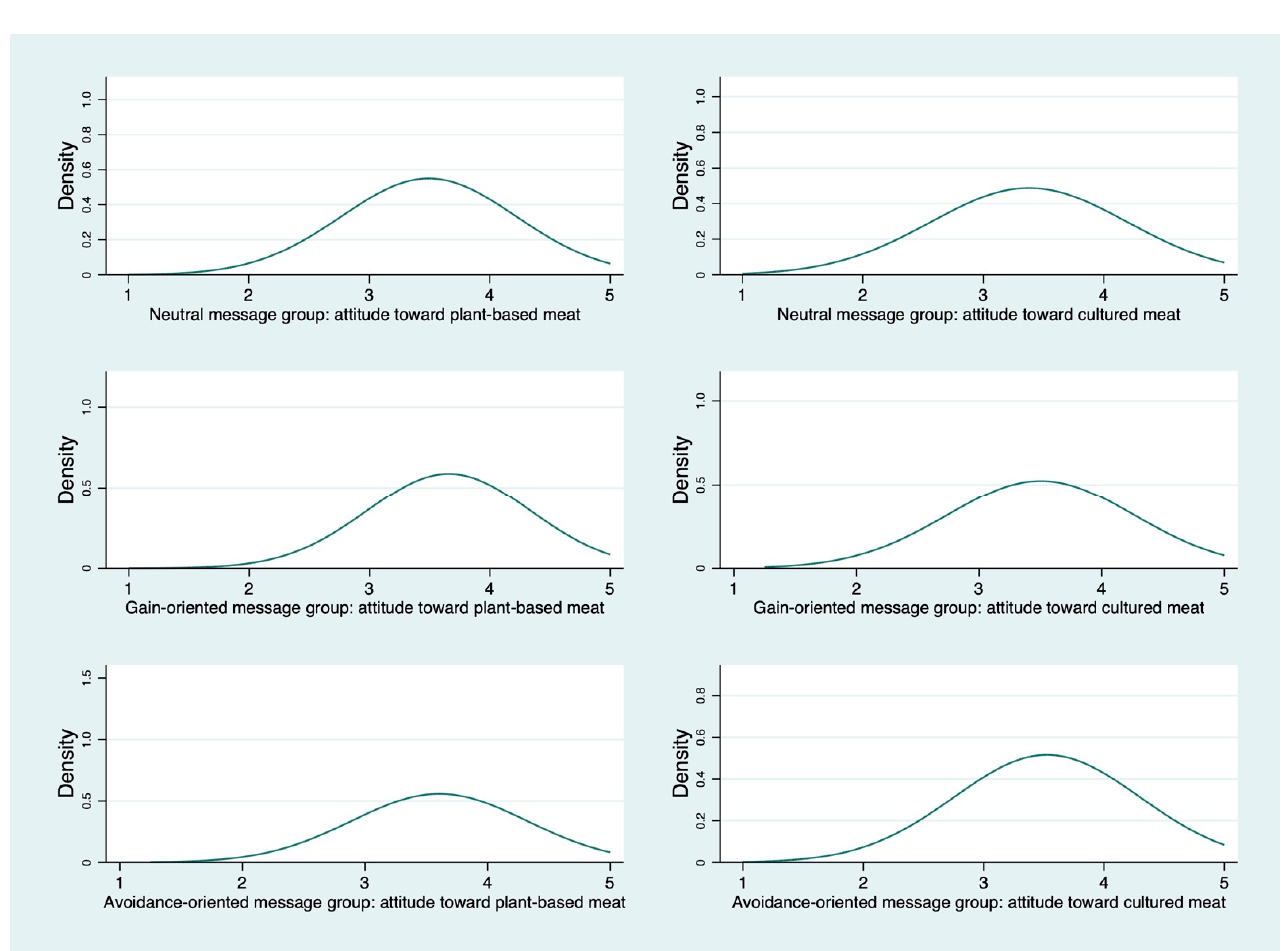
Figure 2. Distribution of consumer acceptance attitudes for each information group.